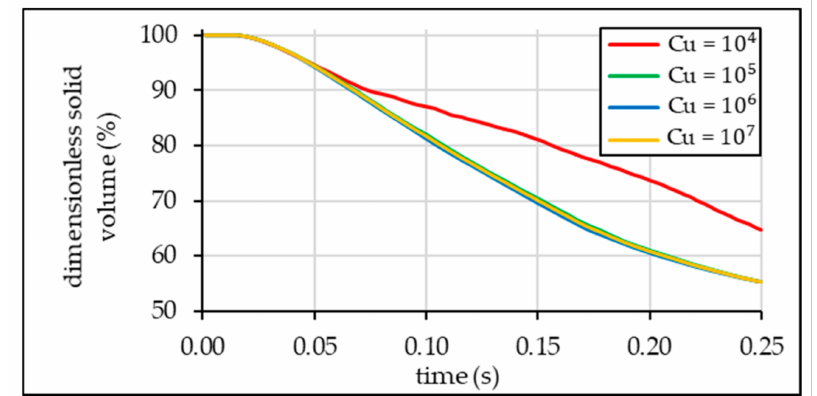
Figure 14. Dimensionless solid volume evolution through time (Fine mesh).